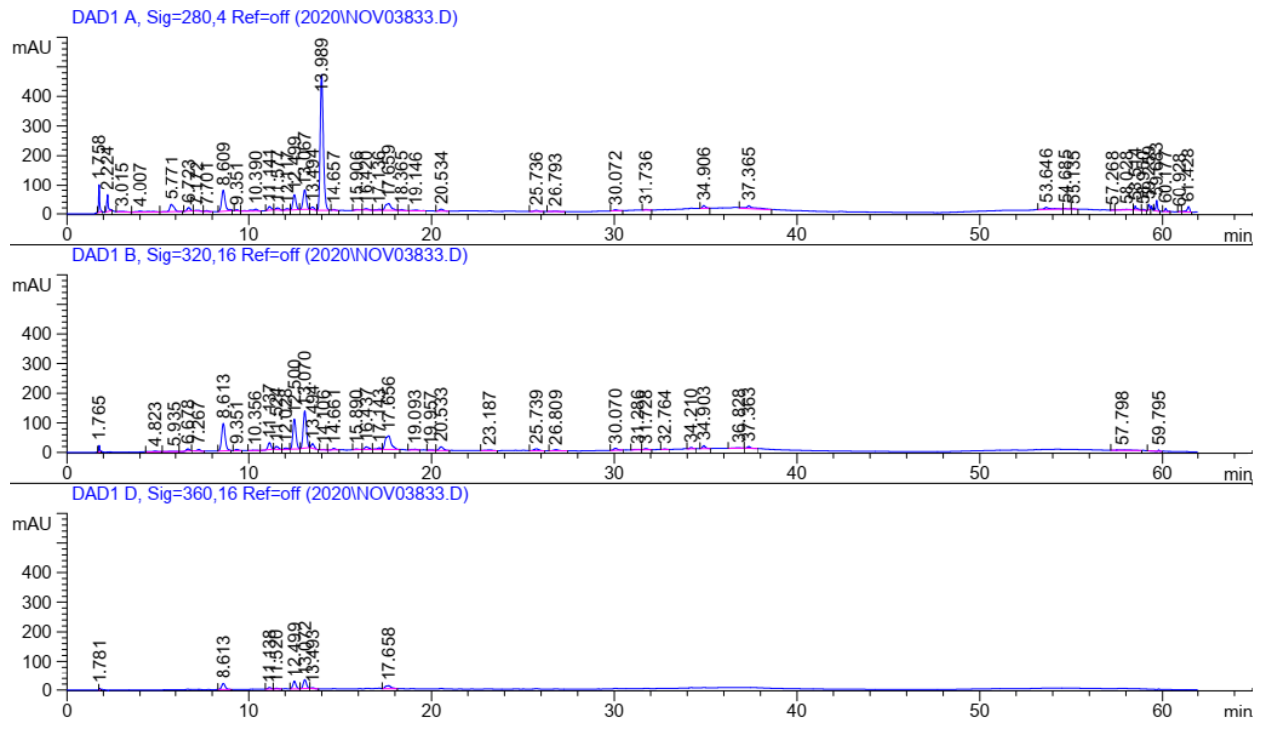
Figure 1. HPLC chromatograms of the methanolic SCG extract at 280, 320, and 360 nm.